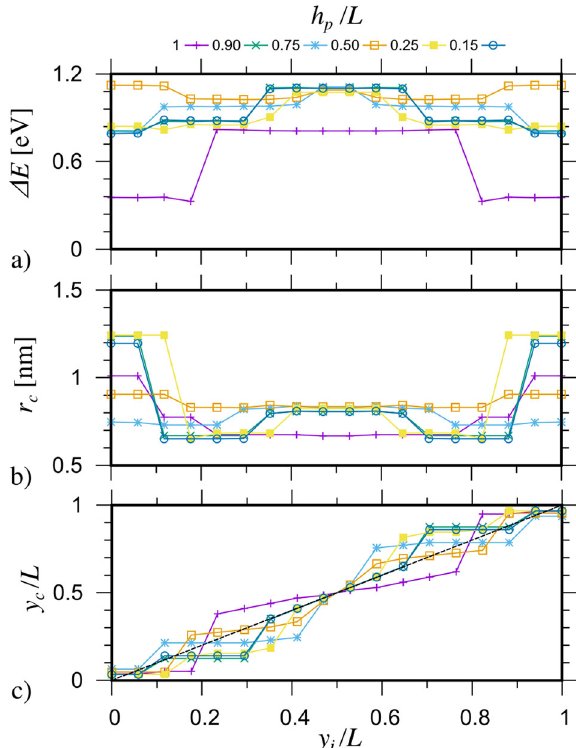
Fig. 3 Side-surface site dependence of dislocation nucleation in a MgO nanocube at ε = 11%. a 0 K activation energy Δ E , b critical dislocation radius r c and c relaxed position of the nucleation centre y c / L , as a function of the initial position y i / L